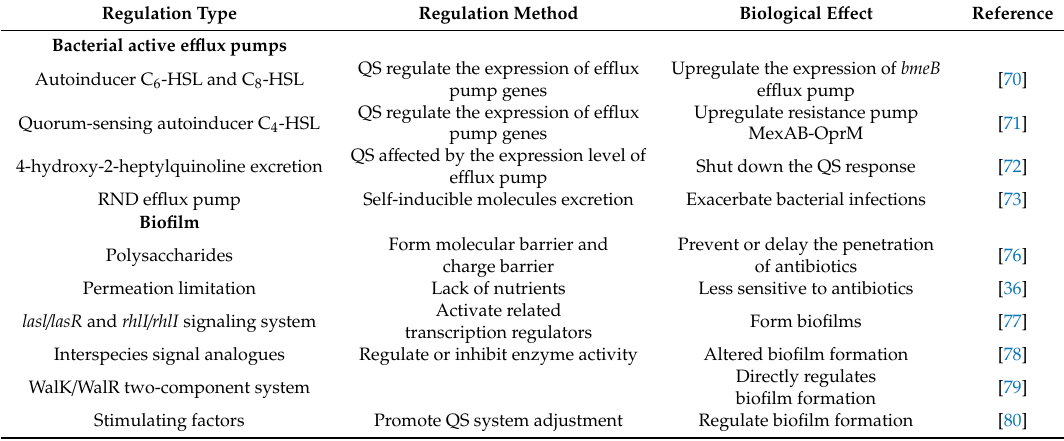
Table 2. Regulation of microbial resistance by quorum